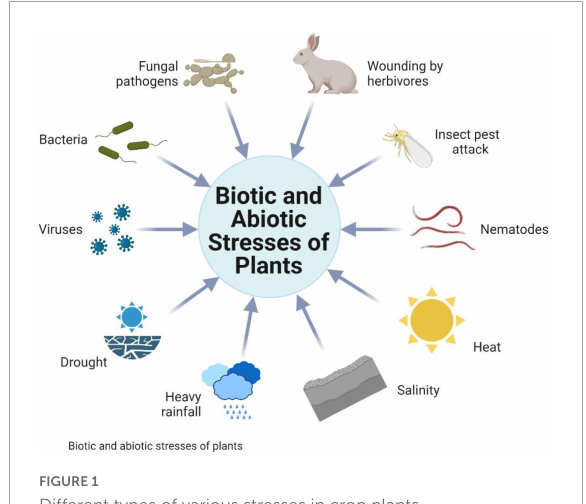
FIGURE1 Different types of various stresses in crop plants.